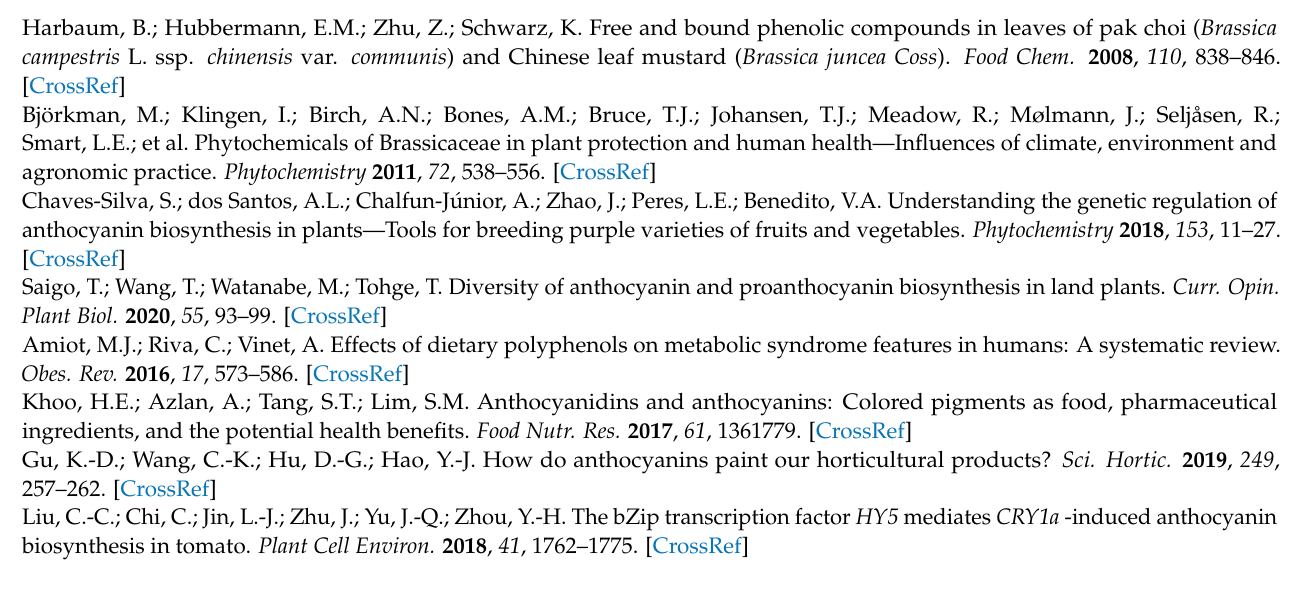
Figure S1: effects of blue and UVA light on the canopies of red- (A) and purple-leaf (B) pak choi. T0, T5, T10 and T20 mean 0 UVA with 50 B, 5 UVA with 45 B, 10 UVA with 40 B and 20 UVA with 30 B ( µ mol · m − 2 · s − 1 ),